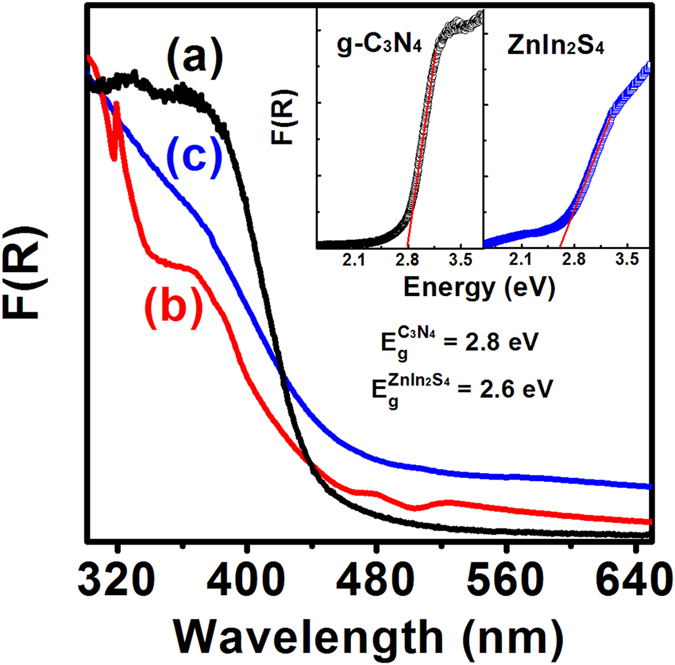
UV-Vis absorption spectra of the as-synthesized samples: (a) g-C3N4 nanosheets, (b) 15 wt% ZnIn2S4/g-C3N4 heterojunction nanosheets, and (c) ZnIn2S4 nanosheets; insets showing the plots of the F(R) versus energy for the g-C3N4 and ZnIn2S4 nanosheets.